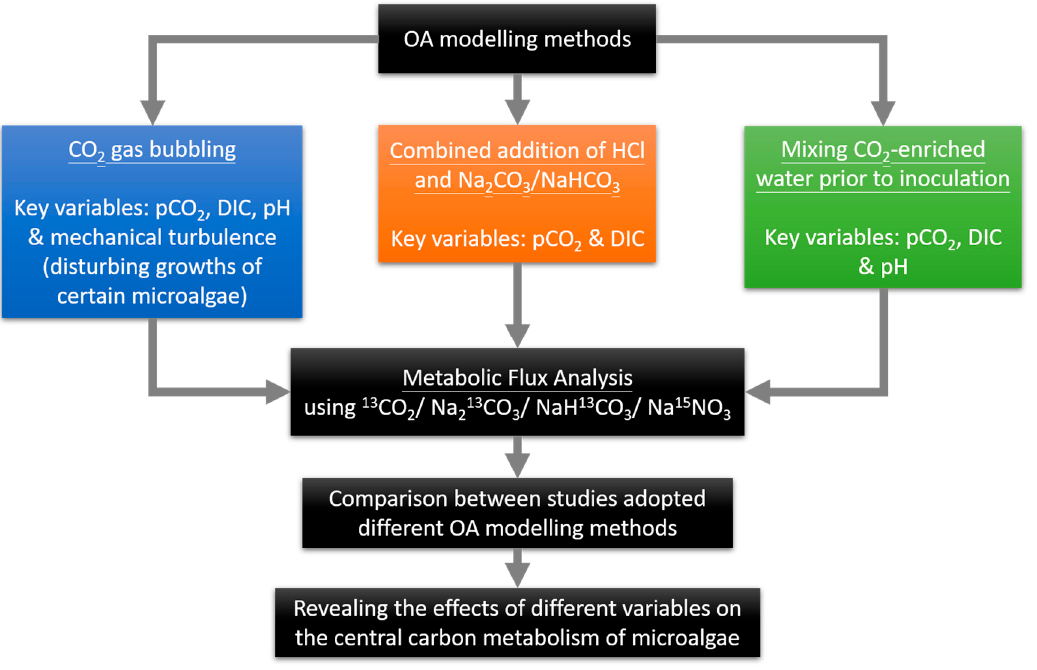
Figure 1. Schematic diagram illustrating the use of metabolomics to elucidate the individual effects of confounding factors on the carbon allocation of microalgae. of confounding factors on the carbon allocation of